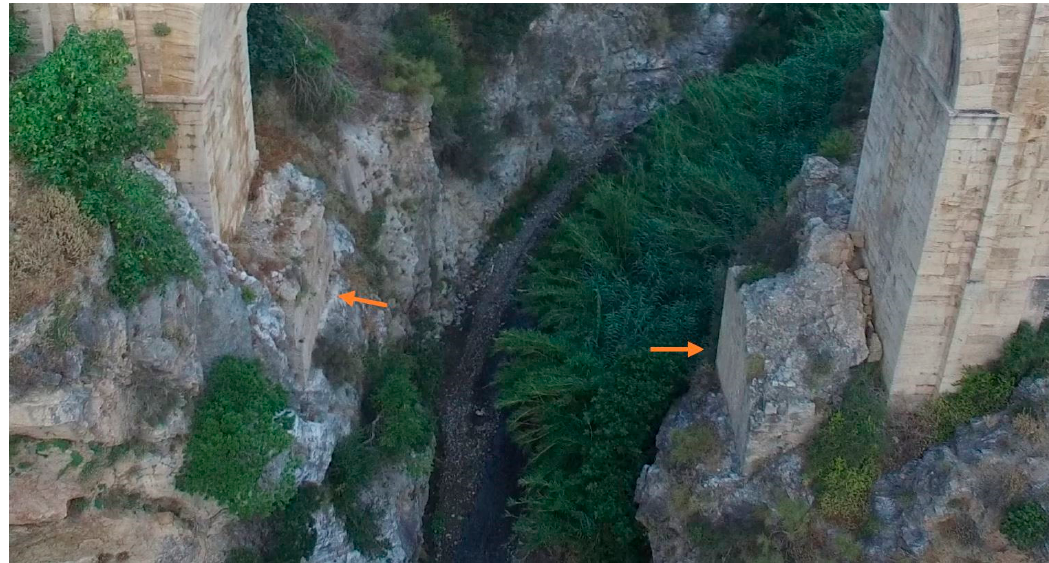
Figure 3. Orange arrows indicate the remains of the 18th-century bridge.